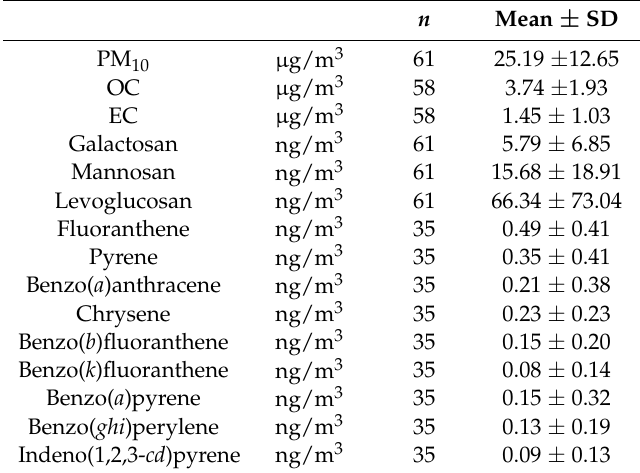
Table 1. Chemical composition of PM 10 in the urban site Borgerhout (number of sampling days ( n ), mean ± SD).